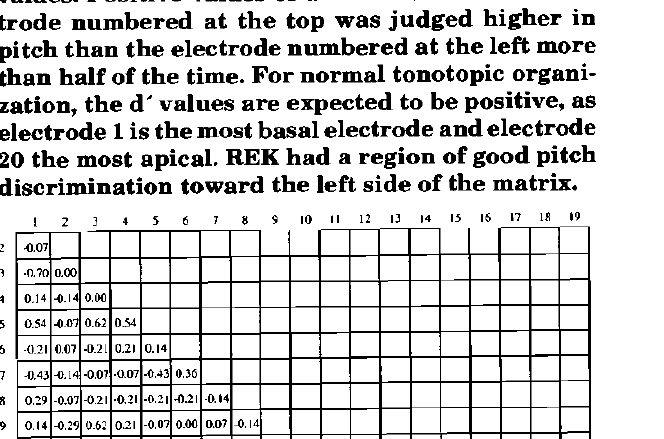
FIGURE 1. Pitch discrimination matrix for subject JEM for BP+1 mode of stimulation. Positive values of d' in the table indicate that the electrode num- bered at the top was judged to have a higher pitch than the electrode numbered at the left, d' values of 3.29 indicate 100% consistency in pitch judgement and values higher than 1.5 indicate an 85% consist- ency. JEM had a large area of good pitch discrimi- nation.